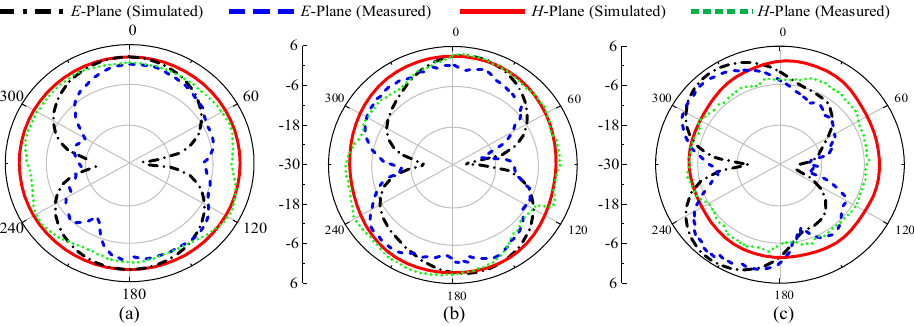
Figure 11. Radiation patterns of the proposed antenna for multiband mode: ( a ) 2.45 GHz, ( b ) 5.2 GHz, and ( c ) 8 GHz.